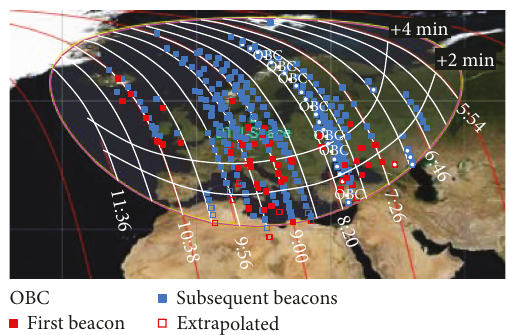
Figure 13: Map of the beacon counter data received by the DTUsat ground station. The white lines are guiding lines used to aid the placement of the beacon dots. Red dots indicate fi rst beacon after a reboot. Blue squares indicate a beacon number higher than 1. The letter group OBC indicates an OBC beacon. The white dots mark beacon from a small recording campaign a few months after the main recording campaign. All the dots are placed using the approach described in the troubleshooting methods section; however, the UTC times indicated at the perimeter are the ones that relates to the main (and largest) recording